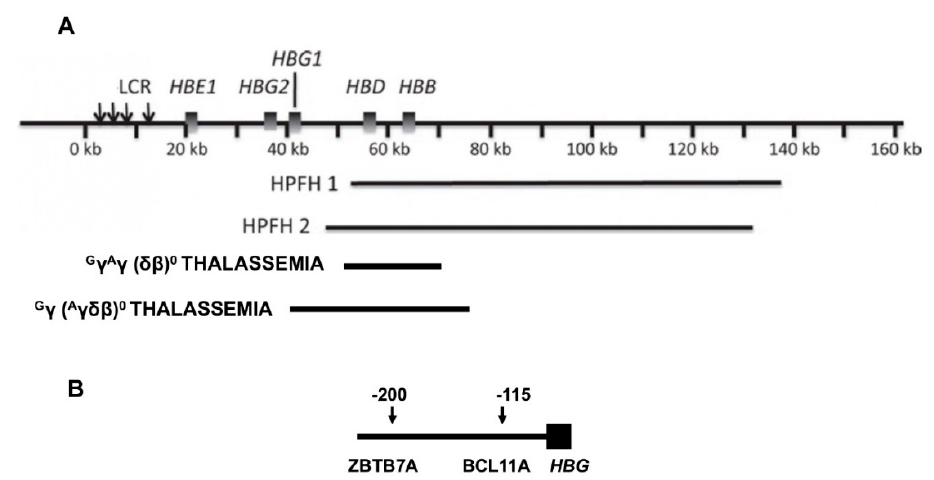
Figure 1. Deletions in the HBB gene cluster associated with increased HbF. ( A ) Displayed are the genes in the HBB gene cluster. The locus control region (LCR) that is upstream of HBE forms contacts with the promoters of the genes in this cluster affecting their transcription. When HBB and HBD are deleted, interactions between the promoters of the γ -globin genes and the LCR are favored. Beneath the HBB gene cluster are shown the locations and approximate sizes of common HPFH and δβ thalassemia deletions. ( B ) At positions − 115 and − 200 upstream of both HBG2 and HBG1 are binding motifs for the γ -globin gene repressors, ZBTB7A at − 200 bp and BCL11A at − 115 bp, respectively. Point mutations and small deletions in these regions and in nearby sites in the promoters, as detailed in Table 2, cause HPFH by altering the binding of these and other transcription factors.